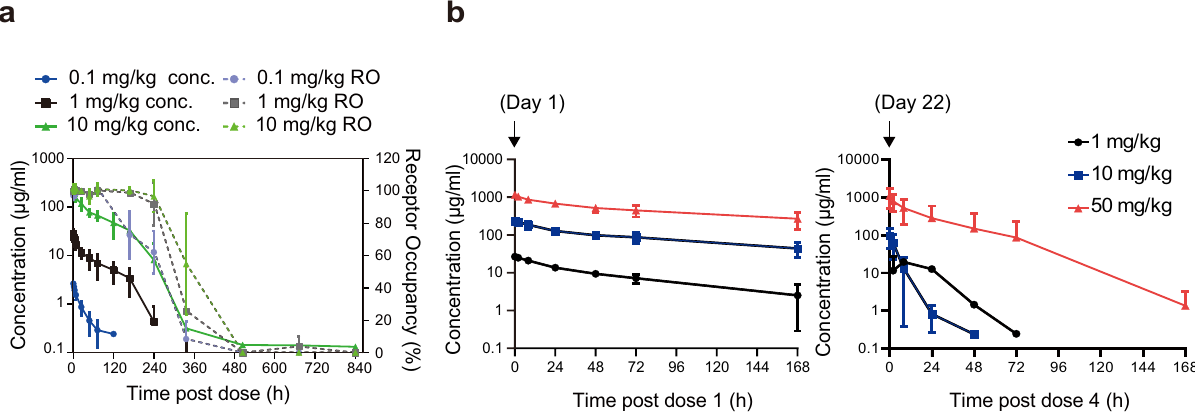
Fig. 4 IBI319 is a tolerated molecule with an IgG-like pharmacokinetic (PK) pro fi le suitable for further clinical development. a Serum concentrations and receptor occupancies of IBI319 in cynomolgus monkeys following a single intravenous administration of 0.1 mg/kg, 1 mg/kg, or 10 mg/kg. n = 6 per group (three males and three females). conc. concentration, RO receptor occupancy, mean and SD. b Time-concentration curves of IBI319 following the fi rst (day 1) and fourth (day 22) intravenous administrations of 1 mg/kg, 10 mg/kg, or 50 mg/kg IBI319 into cynomolgus monkeys. n = 10 per group ( fi ve males and fi ve females); mean